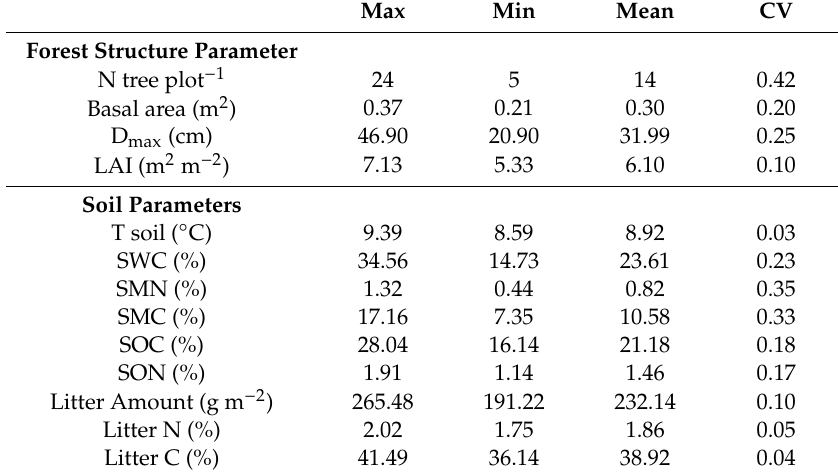
Table 1. Descriptive statistics of forest structural and soil parameters used to assess the relation with the FRP in the 9 sampling plots. Maximum (Max), minimum (Min), mean (Mean), and coe ffi cient of variation (CV) values are reported for each parameter. N tree plot-1 is the number of tree inside each sampling plot; basal area (m 2 ) is the sum of the stem cross-section areas of the n trees present in each plot; D max (cm) is the maximum diameter measured in the sampling plot tree height; LAI (m 2 m − 2 ); T soil ( ◦ C) is the average soil temperature measured during the SR campaigns ( n = 11); SWC (%) is the annual average soil water content measured during the SR campaigns, except February 2008 because of the snow cover ( n = 10); SMN (%) is the organic nitrogen percentage in the mineral soil layer; SMC (%) is the organic carbon percentage in the mineral soil layer; SON (%) is the organic nitrogen percentage in the organic soil layer; SOC (%) is the organic carbon percentage in the organic soil layer; litter amount (g DW m − 2 ); litter N (%) and litter C (%) are the nitrogen and carbon percentages of the litter, respectively. Max Min Mean CV Forest Structure Parameter N tree plot − 1 24 5 Basal area (m 2